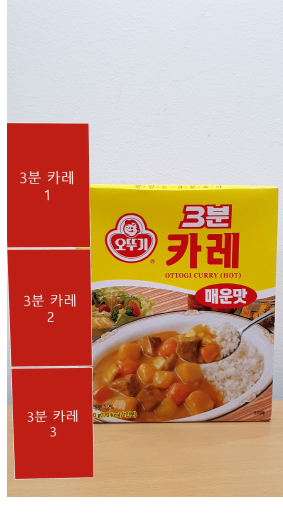
Figure 4. Three AR content positions.